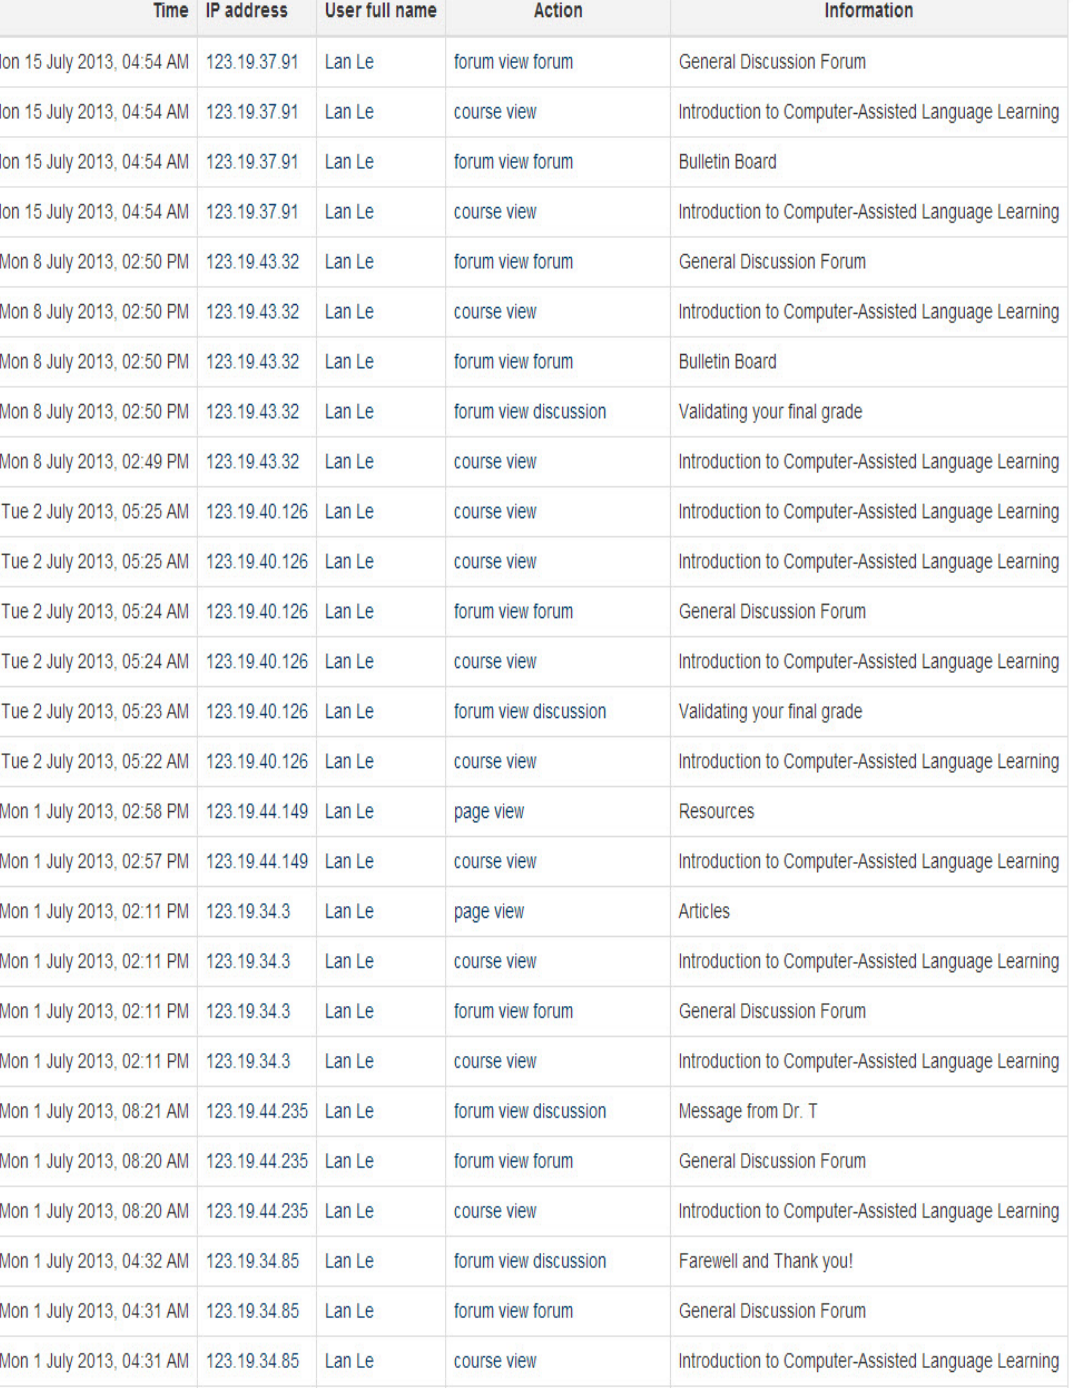
Figure 1 . Screenshot of a learner’s login